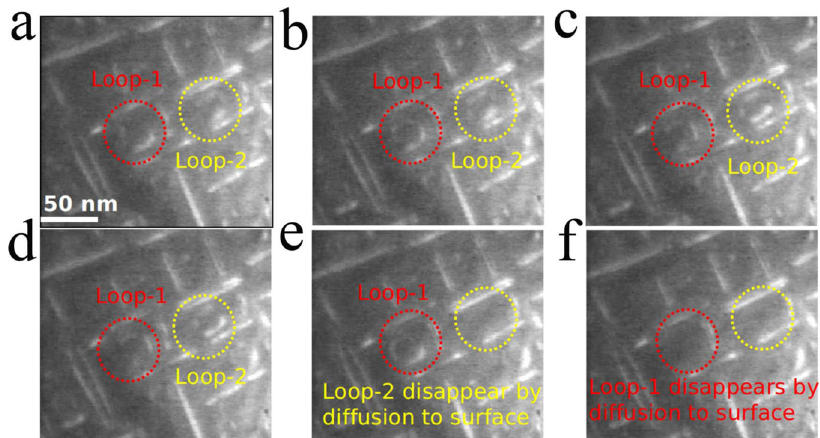
Fig. 6 Indirect evidence of <100> loop diffusion through the change of their habit planes. a – f The rotation of habit planes between the {100} and the {110} during their diffusion to the surface along the Burgers vector. Two loops are shown by small red and yellow dot circles, respectively.